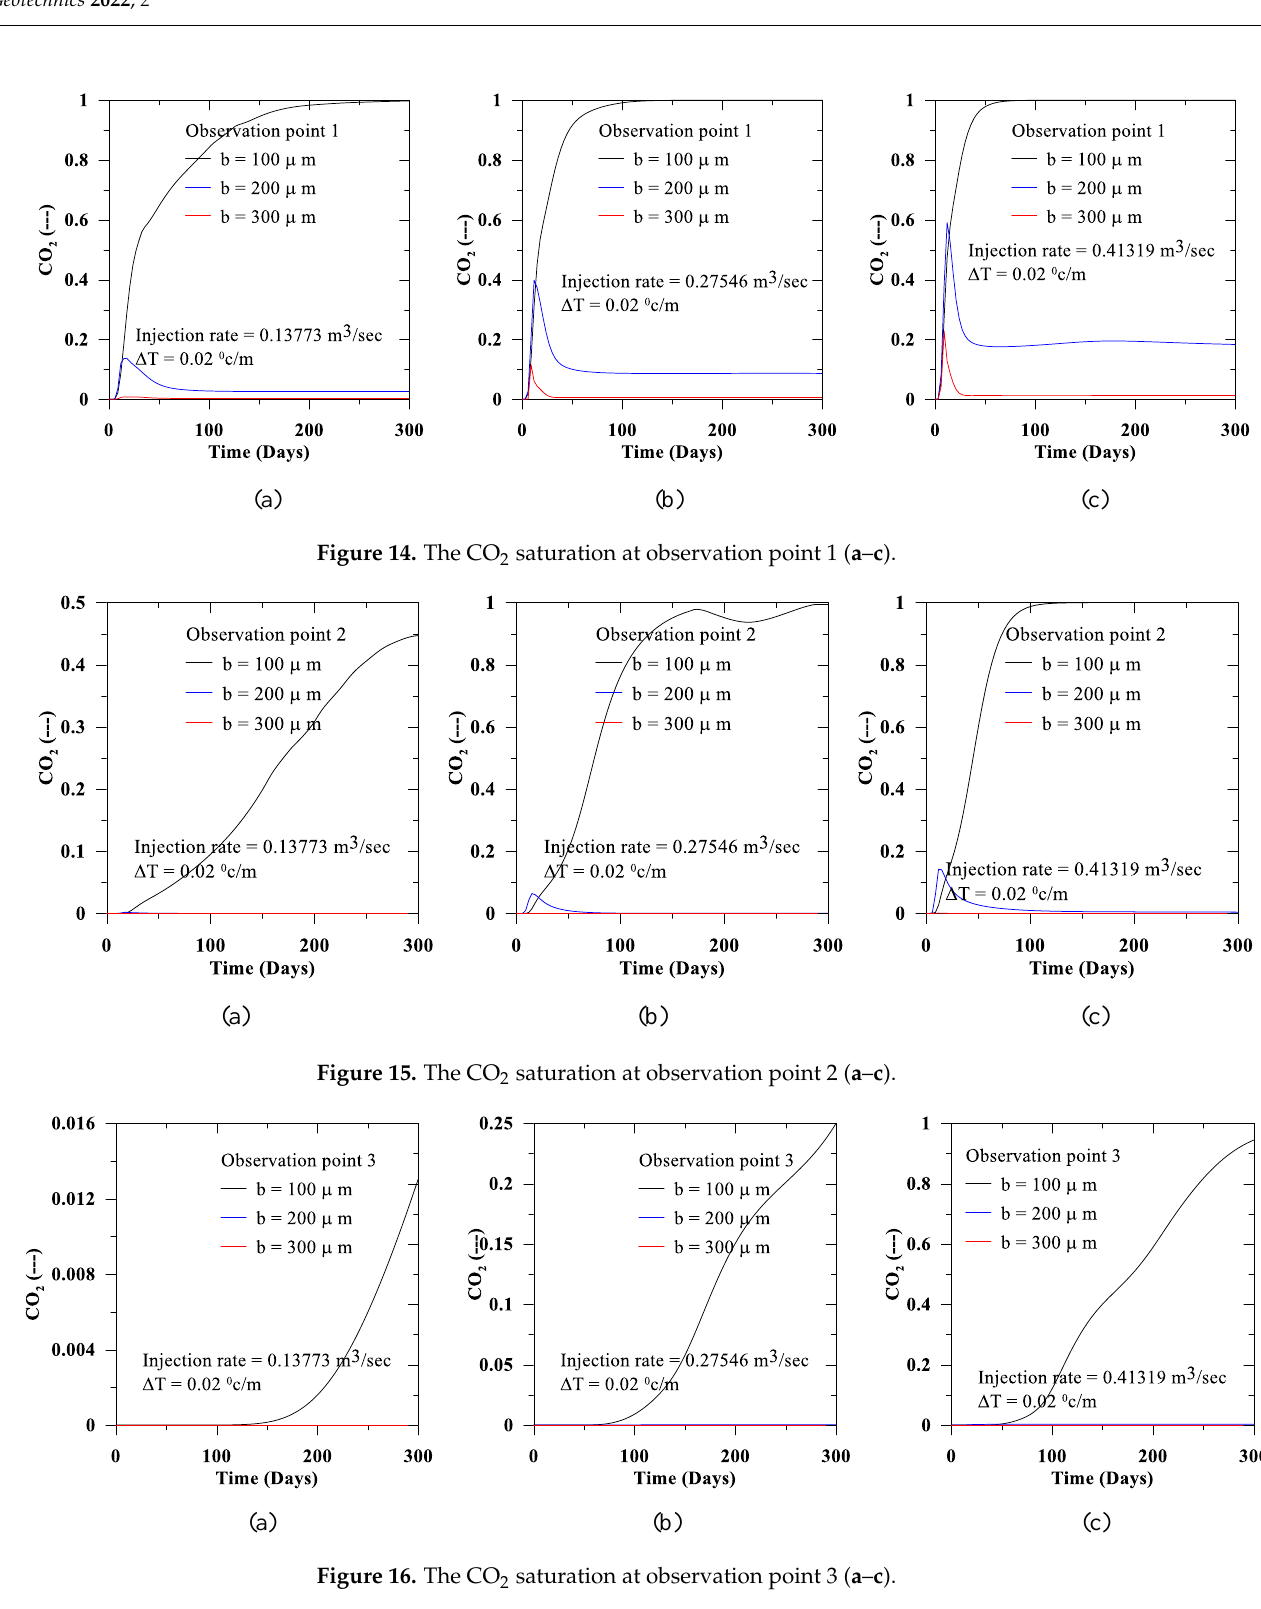
15 Figure 13. The pressure distribution ( a – c ) in observation point 3.